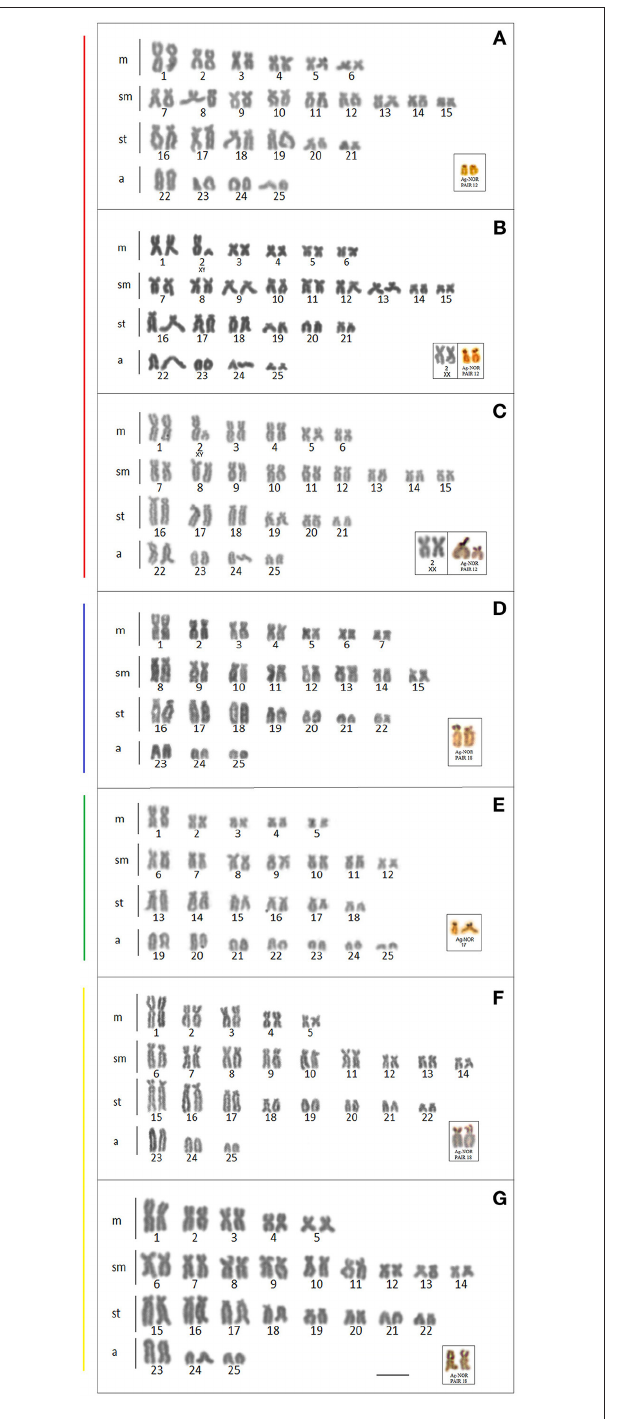
FIGURE 4 | Karyotype of the Ancistrus populations sampled in different rivers of the Paraná basin, stained with Giemsa. The configuration of the silver nitrate-stained nucleolar organizing regions (Ag-NORs) are shown in the box. Each color of the side bars represents one of the evolutionary lineages recovered in the analysis, according to Figure 2 . (A) L1: Mourão River; (B) L2: 19 Stream; (C) L3: Keller River; (D) L6: São Francisco Verdadeiro River; (E) L8: Ancistrus cirrhosus ; (F) L9: Ocoí River; (G) L10: São Francisco Falso River. Bar = 10 µ m.